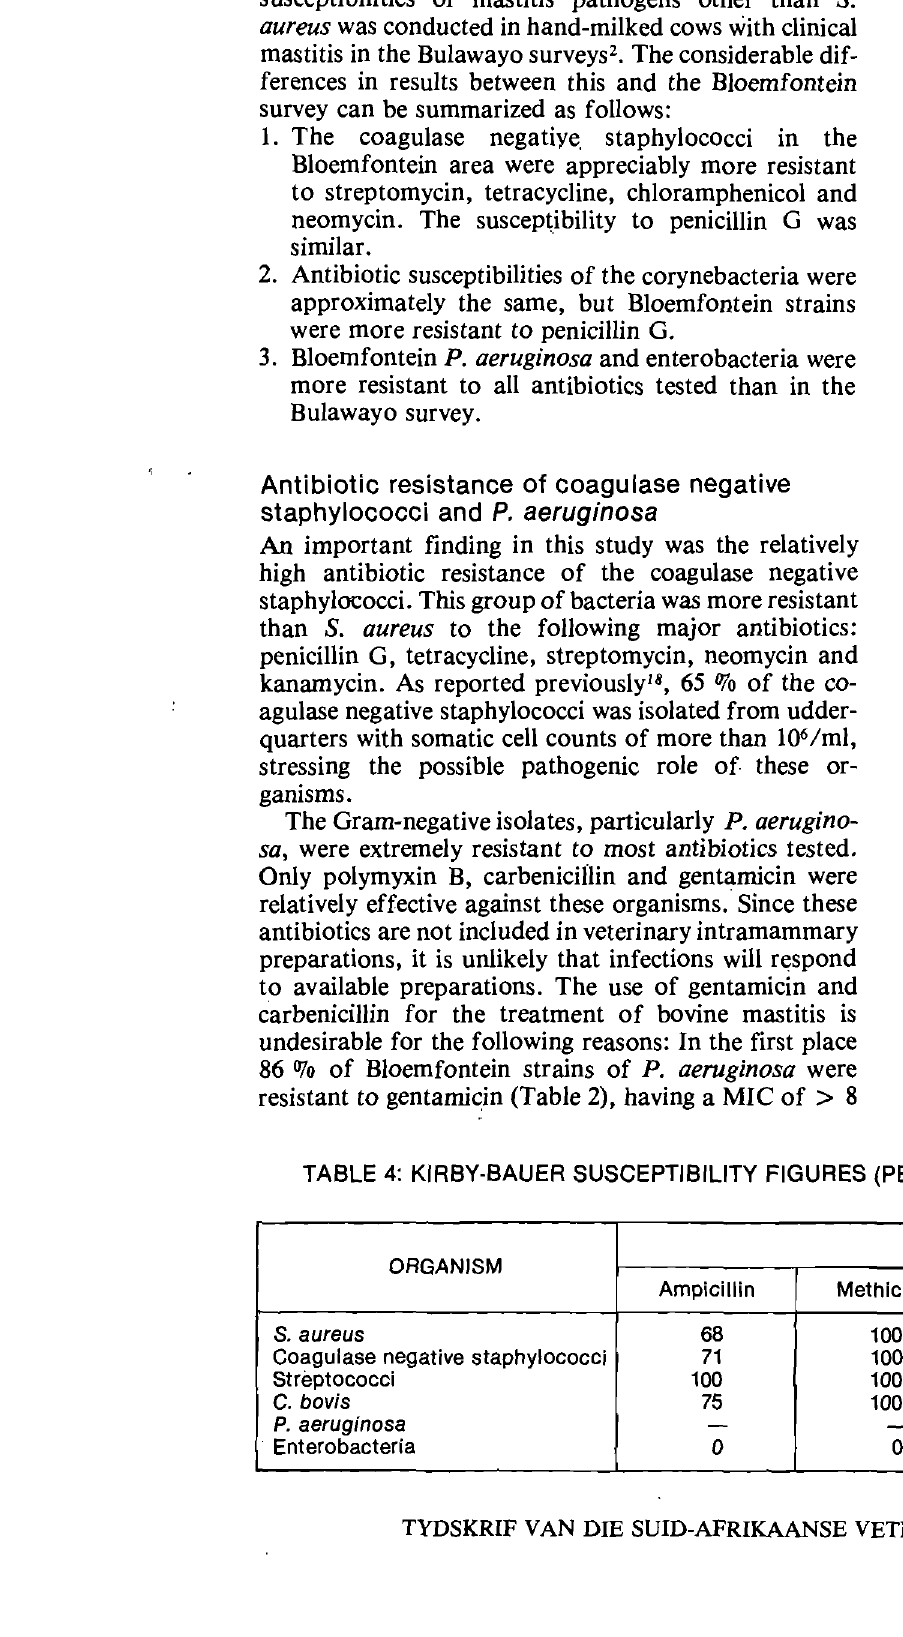
TABLE 4: KIRBY-BAUER SUSCEPTIBILITY FIGURES (PERCENTAGE FOR COMMONLY USED ANTIBIOTICS)